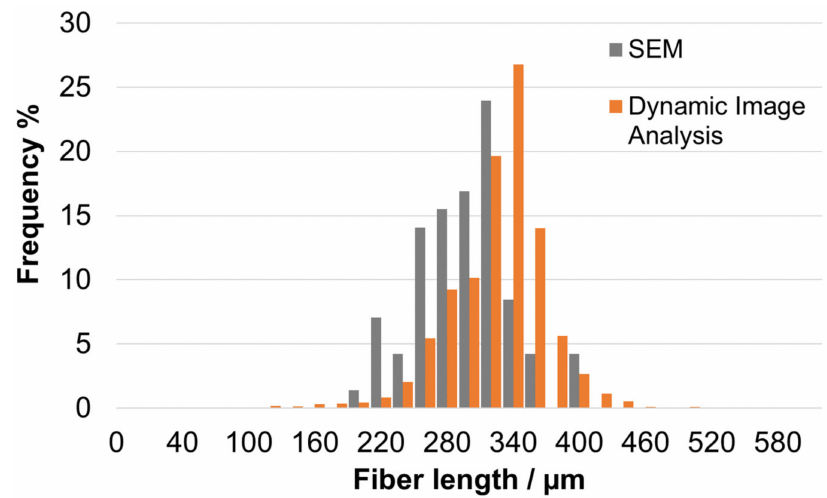
Figure 3. Distribution of the fiber length (0.3 mm polyamide 6.6 reference fibers) determined by scanning electron microscopy (SEM, grey columns) and dynamic image analysis (orange